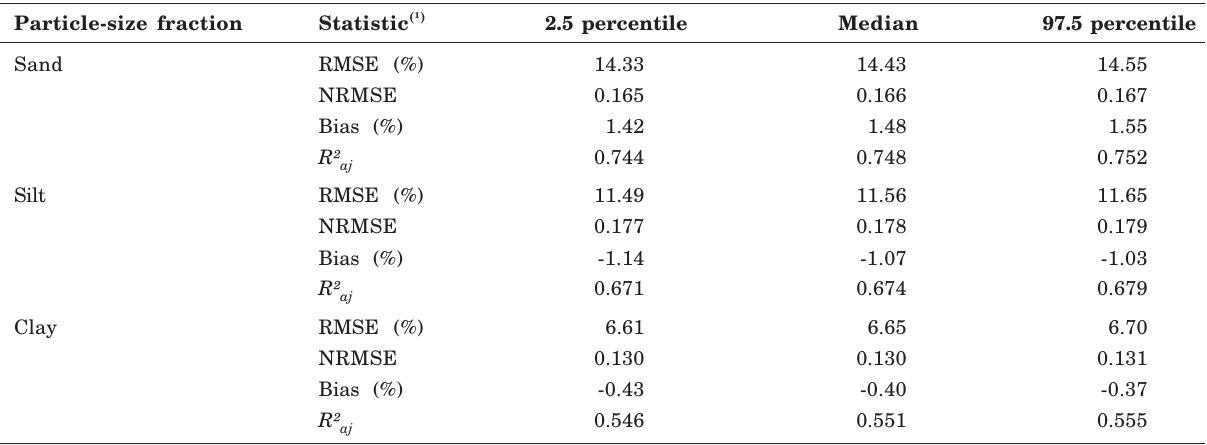
Table 2. Cross-validation statistics (10-fold; 100 repetitions) for prediction of particle-size distribution based on application of the predictive models